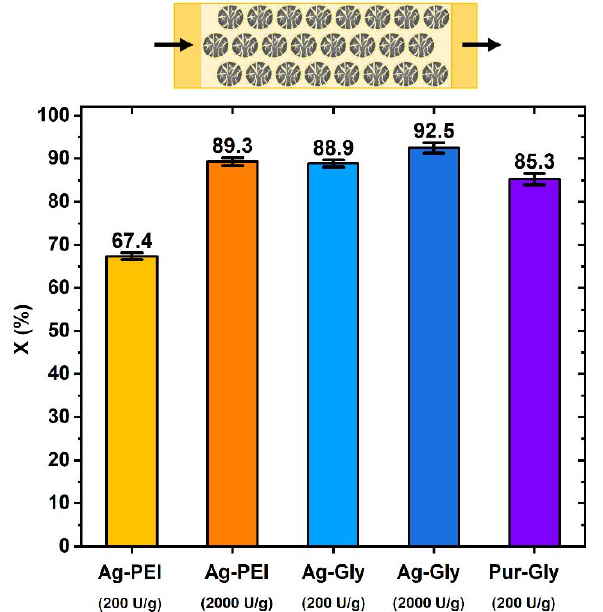
Figure 8. Cellobiose conversion in the operation in fixed ‐ bed reactors containing immobilized enzyme: Ag-Gly 2000 U _pNPG /g support (dark blue), Ag-Gly 200 U _pNPG /g support (light blue), Ag-PEI 2000 U _pNPG /g support (orange), Ag-PEI 200 U _pNPG /g support (yellow) and Pur-Gly 200 U _pNPG /g support (purple). All reactions were performed at 23.5 ◦ C with a residence time of 19.4 min employing as substrate a solution of cellobiose 100 mM (sodium citrate buffer 50 mM pH 5.0).